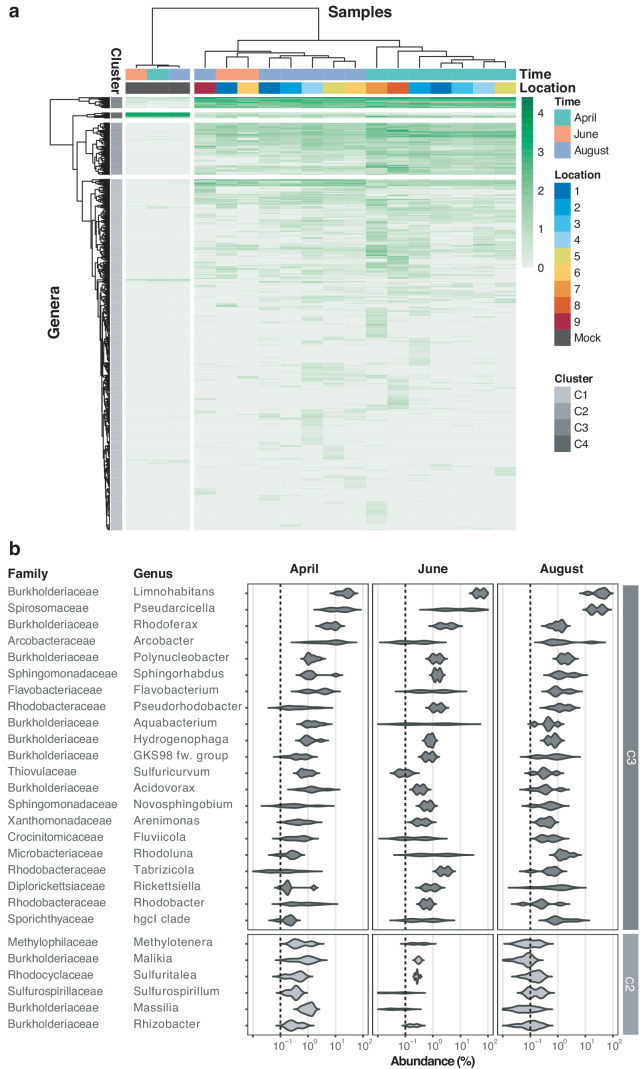
River Cam core microbiome analysis on the bacterial genus level.(a) Hierarchical clustering of bacterial genera abundances across freshwater samples after rarefaction, together with the mock community control. In similarity to the family analysis displayed in Figure 4, bacterial genera are clustered into four groups. Two of these (C3 and partially C2) correspond to the core microbiome of ubiquitously abundant genera, one (C4) corresponding to the main mock community genera and one (C1) corresponding to the majority of rare accessory taxa. (b) Dominant river core microbiome on the genus level. Violin plots (log10 scale of relative abundance [%] across all samples, nApril = 7, nJune = 2, nAugust = 6) summarise fractional representation of the top 27 bacterial genera and corresponding families from clusters C2 and C3, sorted by median total abundance. Vertical dashed line depicts 0.1% proportion. Out of the top 16 core families (Figure 4b), only the NS11-12 marine group family was found not to be represented on the genus level; NS11-12 marine group genera are mainly composed of uncultured bacteria, which here could not be classified at higher resolution.